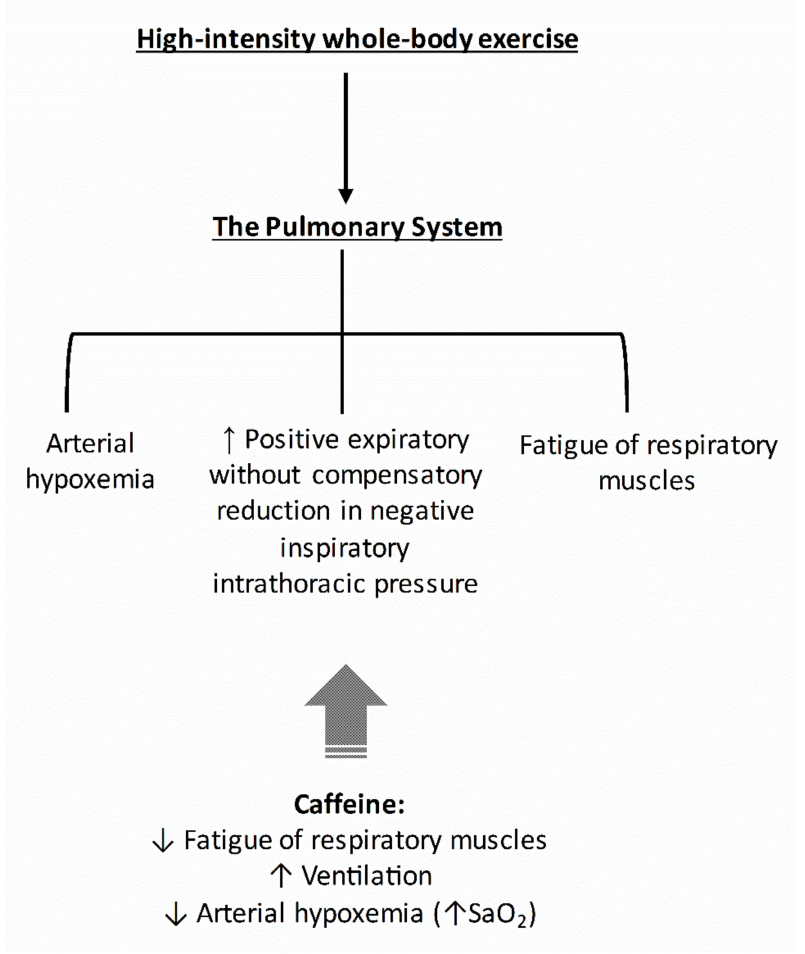
Figure 3. Main physiological events within the pulmonary system that might contribute to fatigue during high-intensity whole-body exercise. The potential influence of caffeine on components of the pulmonary system that might explain part of its ergogenic effect is also indicated. Caffeine reduces fatigue of respiratory muscles [39] and increases pulmonary ventilation and arterial oxygen saturation